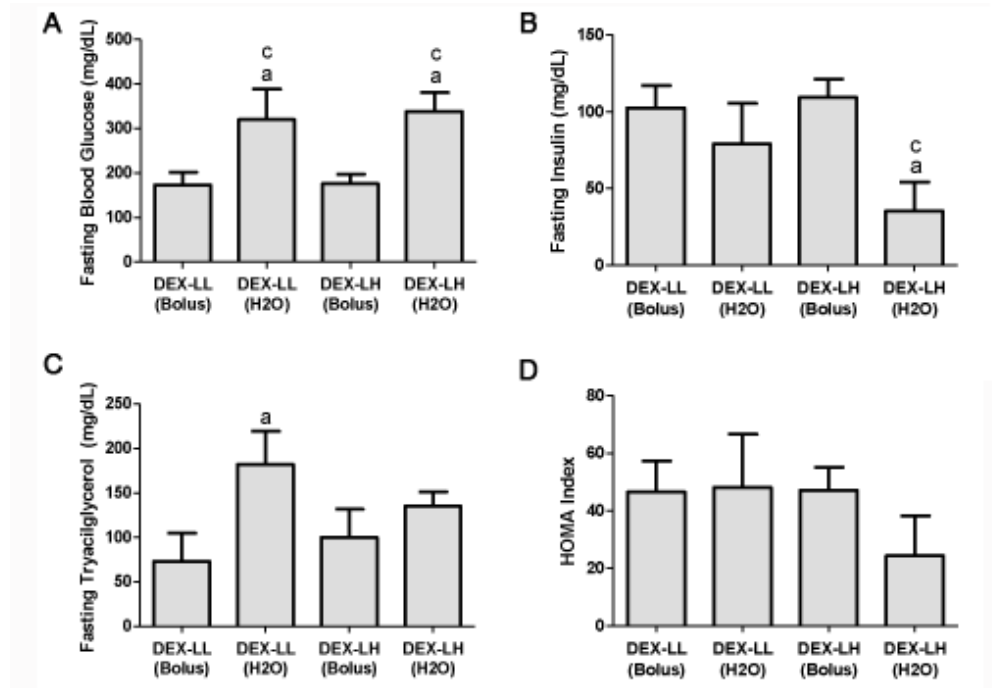
Figure 4. Fasting ( A ) blood glucose, ( B ) insulin and ( C ) triacylglycerol levels